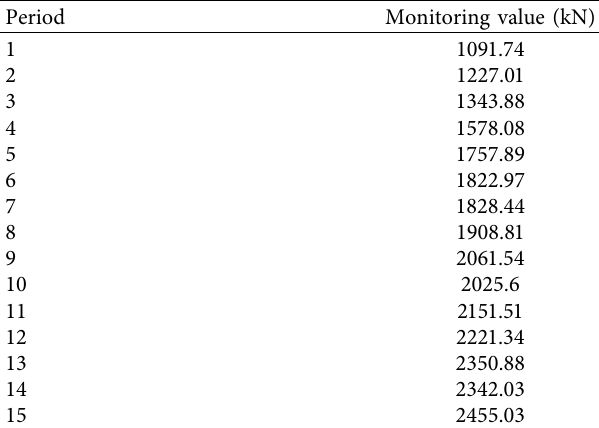
Table 1: ZL2-7 monitoring value.